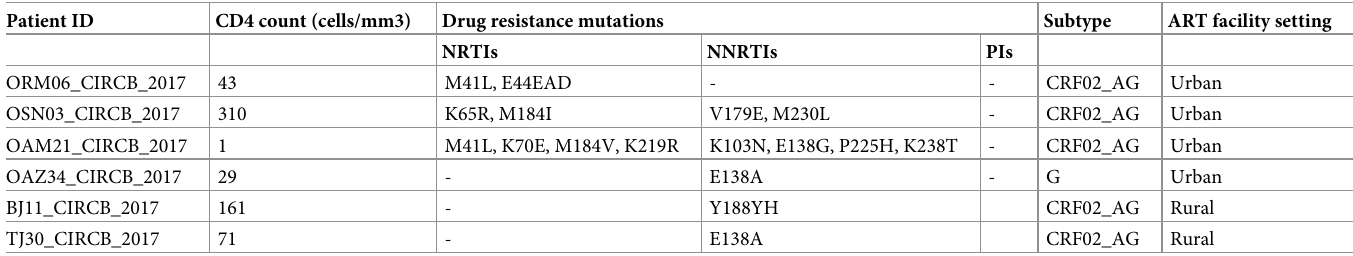
Table 3. Drug resistance mutation